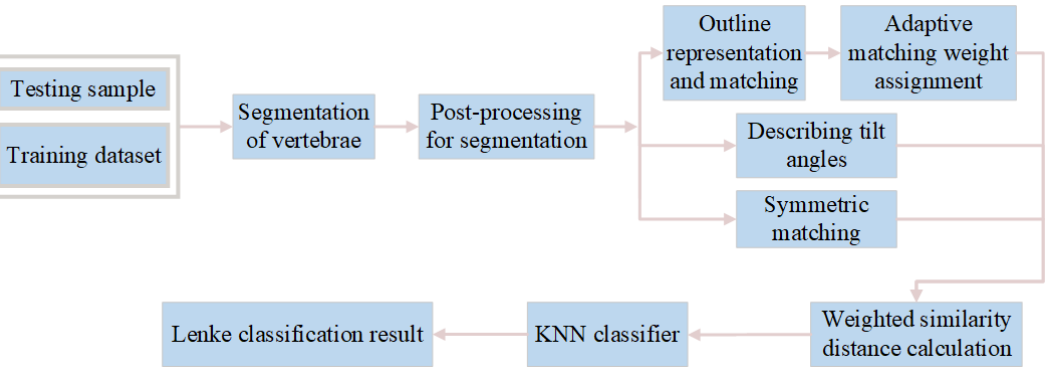
Figure 12. A block diagram of the calculation process of Lenke classification based on shape de- scriptor.